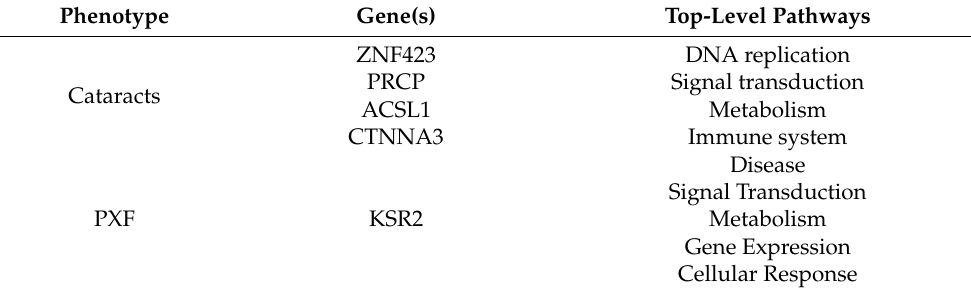
Table 9. Reactome pathway